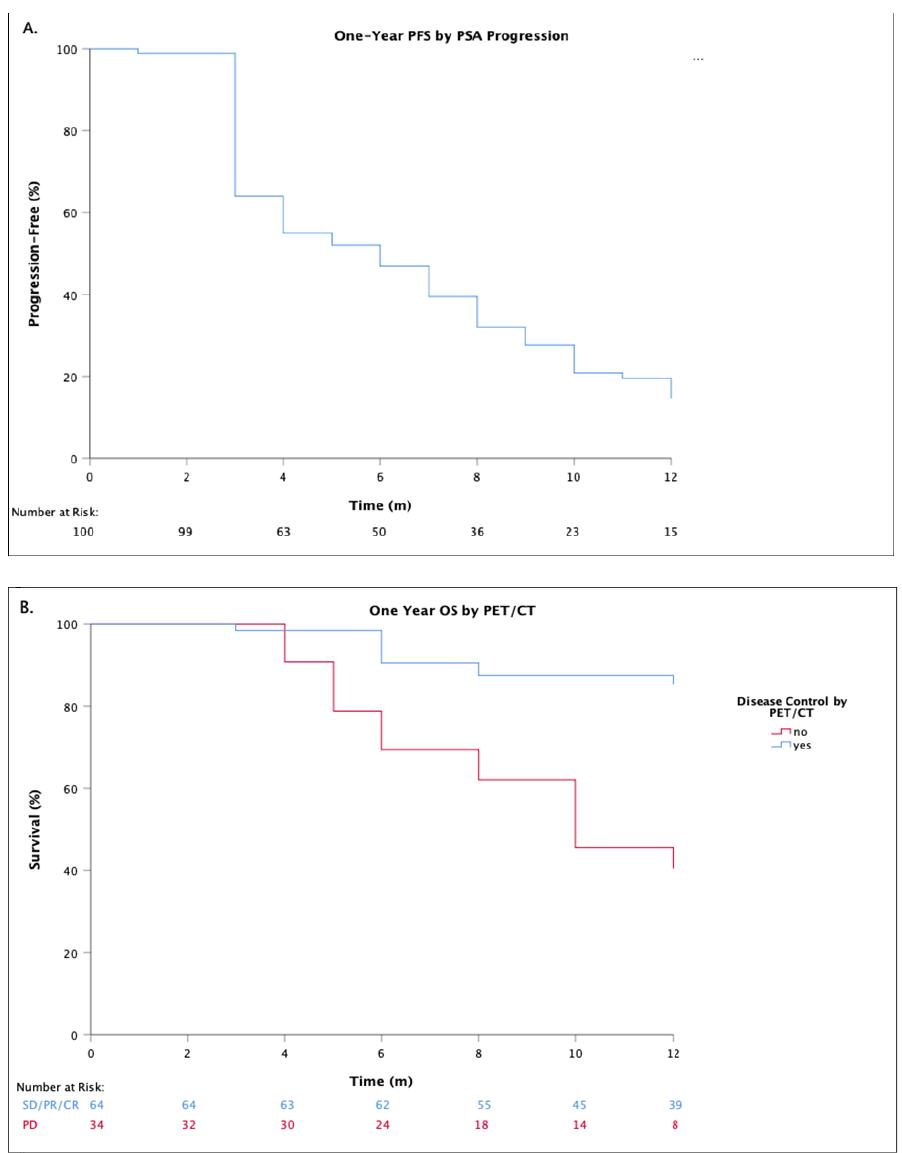
Figure 3. Survival outcomes. ( A ) One-year progression-free-survival (PFS), by prostate specific antigen (PSA) measurement, with progression defined as a > 25% increase in PSA and > 2 ng/mL above nadir, confirmed by progression at two timepoints at least 3 weeks apart; ( B ) One-year overall-survival (OS) stratified by week-12 Gallium-68 prostate specific membrane antigen positron emission tomography/computed tomography (PET/CT) based response. Disease control defined as any patient achieving stable disease (SD), partial-response (PR), or complete response (CR) as per PERCIST, EAU, and EANM consensus criteria [14,15].